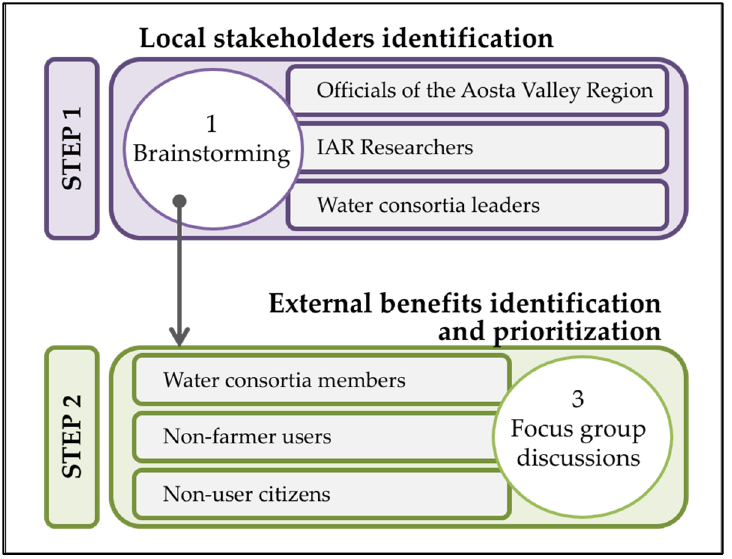
Figure 1. Diagram of methodological approach.